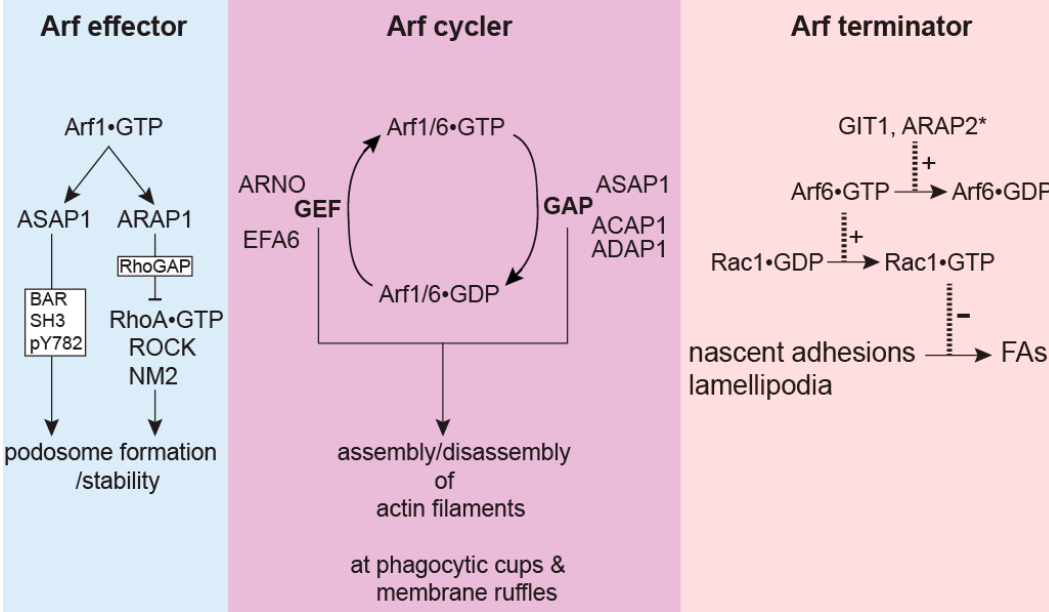
Figure 3. The modes of action that Arf GAPs take to regulate actin and related functions. Arf GAPs regulate actin-based structures and functions by acting like (1) Arf effectors that bind Arf • GTP, propagate and promote Arf functions independent of GAP activity; (2) Arf cyclers that, by working with Arf GEFs, facilitate the cycling of Arfs between GTP and GDP bound states to aid dynamic assembly and disassembly of actin structures, and (3) Arf terminators that reduce Arf • GTP levels and terminate consequent signaling for actin remodeling. Examples for each mode of action are shown. ARAP2* denotes that parts of ARAP2 function in focal adhesions (FAs) are mediated by other mechanisms. + and − mean “promoting” and “inhibiting”